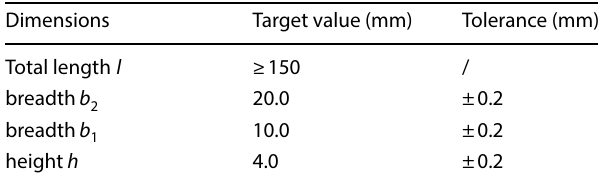
Table 4 Target values in accordance to DIN EN ISO 527–2:2012–06 [19] for the listed dimensions from tensile specimen